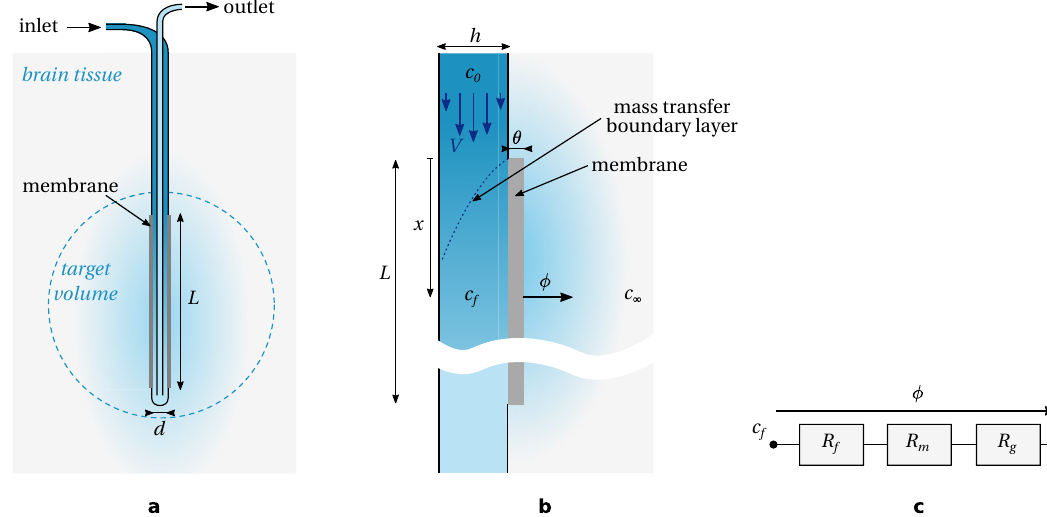
Figure 1. Geometry and theory of operation of retrodialysis. ( a ) Overview of the geometry (cross-section); ( b ) Details, symbols and notation; ( c ) Circuit